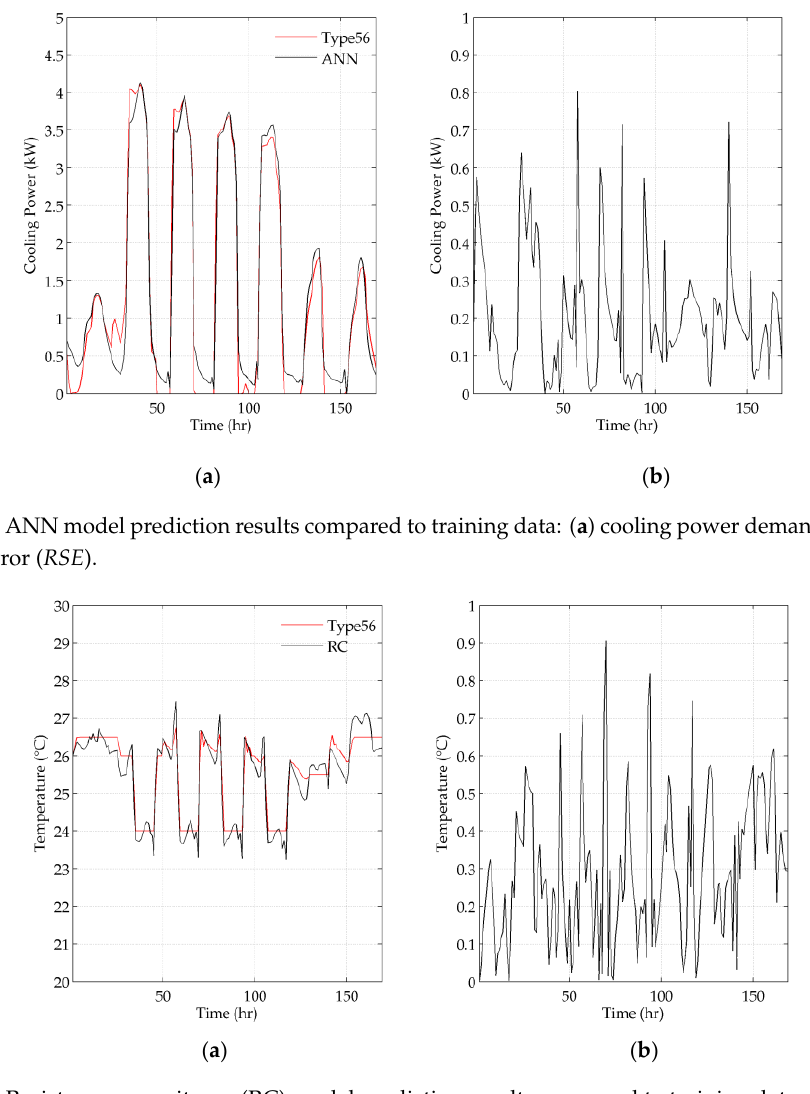
Figure 7. Resistance–capacitance (RC) model prediction results compared to training data: ( a ) indoor air temperature; ( b ) RSE .